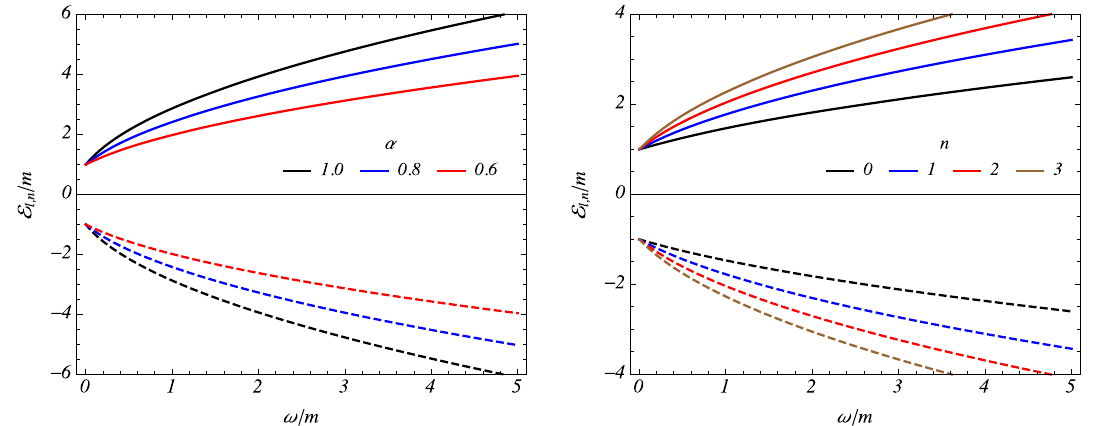
Fig. 1 Energy profile as function of ω/ m for n = 1 (left plot) and α = 0 . 5 (right plot). The full lines are the positive energy while the dashed lines are for the negative energy. In both plots we consider κ = 1 /